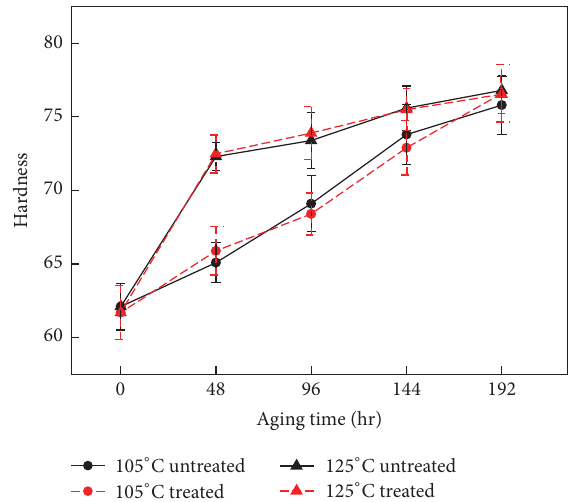
Figure 4: Hardness of the polyketone/NR composite after thermal aging at 105 and 125 ∘ C.